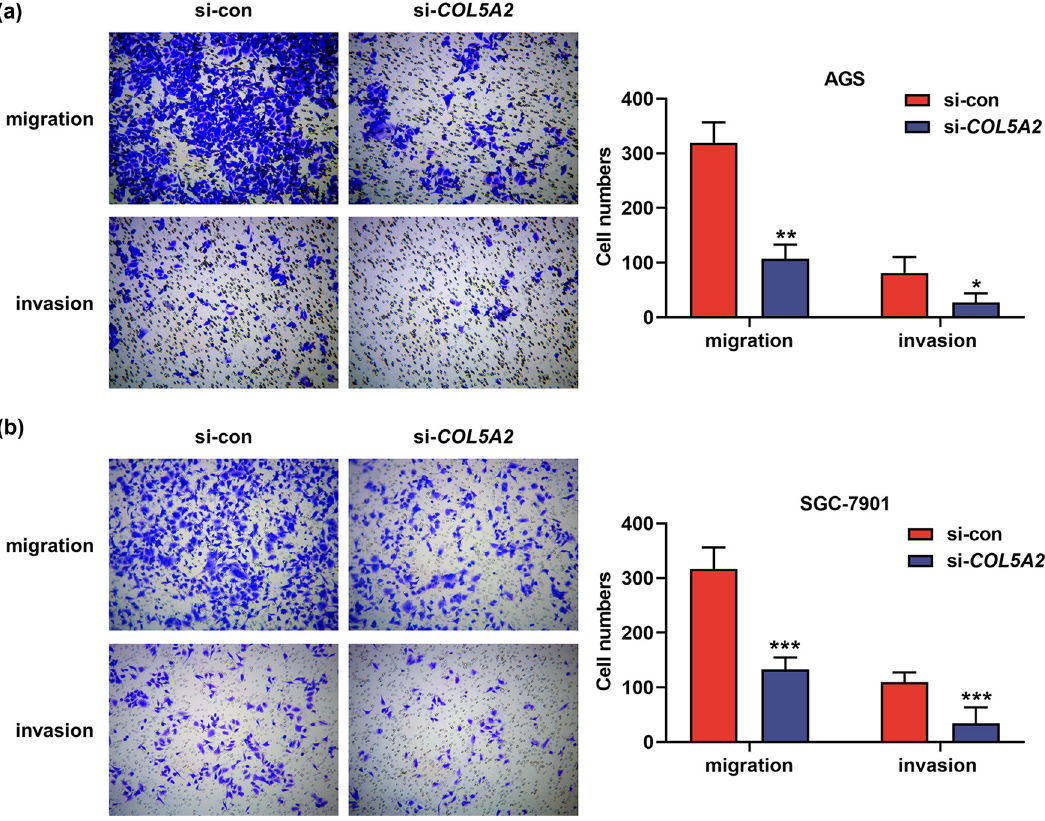
Figure 6: Knockdown of COL5A2 inhibited the migratory and invasive rates of GC cells. ( a and b ) Numbers of migratory and invasive cells in si - COL5A2 - or si - con - transfected AGS ( a ) and SGC - 7901 ( b ) cells were analyzed by transwell assay. Data from three independent experi - ments were described as mean ± SD. * P < 0.05, ** P < 0.01 and *** P < 0.001 vs si - con